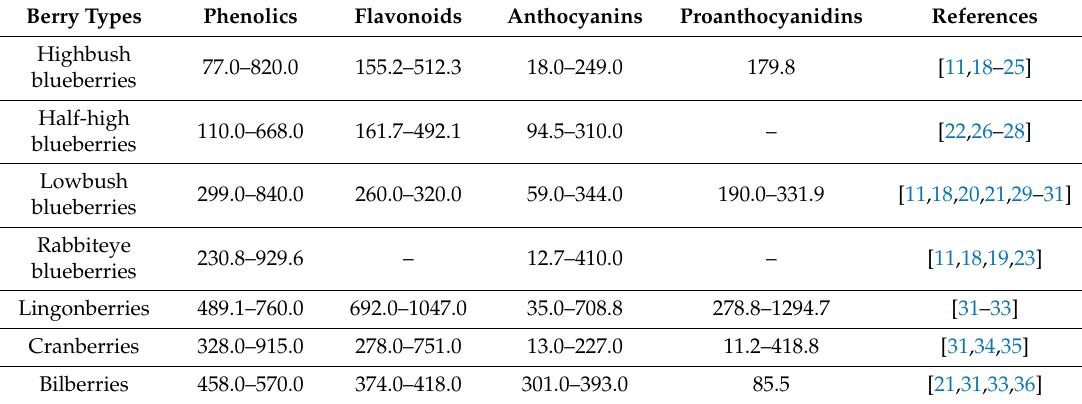
Table 1. Total phenolic, flavonoid, anthocyanin and proanthocyanin contents in Vaccinium berries (mg / 100 g fresh